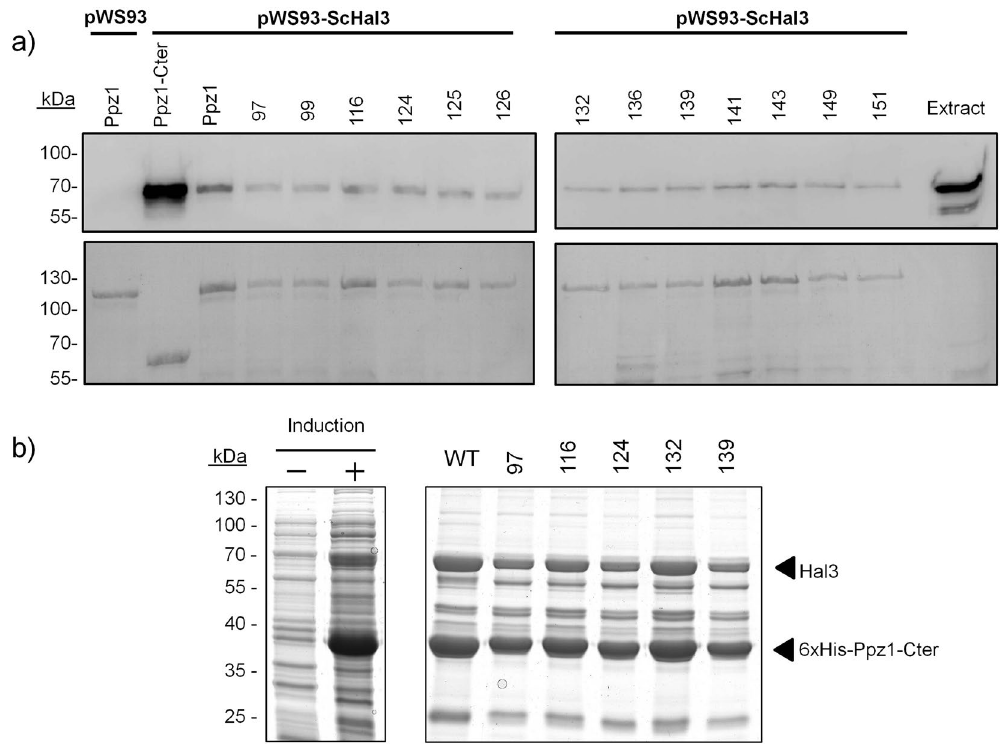
Figure 4. Interaction of Hal3 with the different Ppz1 variants. ( a ) Equal amounts of the indicated versions of GST-Ppz1 were immobilized on glutathione beads and used as an affinity system to recover plasmid-borne HA-tagged Hal3 from extracts of strain IM021 ( ppz1 hal3 ). Beads were washed and processed for SDS-PAGE (8% gels) and immunoblotting using anti-HA antibodies as described in Methods. The lower panel corresponds to the Ponceau-stained membranes, to reveal the amount of Ppz1. ( b ) Co-expression and co-purification of Ppz1 variants and Hal3 in E. coli . Several 6xHis-tagged Ppz1-Cter versions carrying selected mutations were co-expressed together with untagged Hal3 in a polycistronic vector under the T7 promoter. The left panel shows bacterial extracts corresponding to the wild type Ppz1 as an example ( − , non-induced; + , induced). The 6x-His tagged Ppz1-Cter proteins were purified by Ni-NTA agarose affinity chromatography and the protein complex subsequently eluted with buffer containing 500 mM imidazole. Samples (15 μ l) were analyzed by 10% SDS- PAGE and proteins revealed with BlueSafe protein stain.